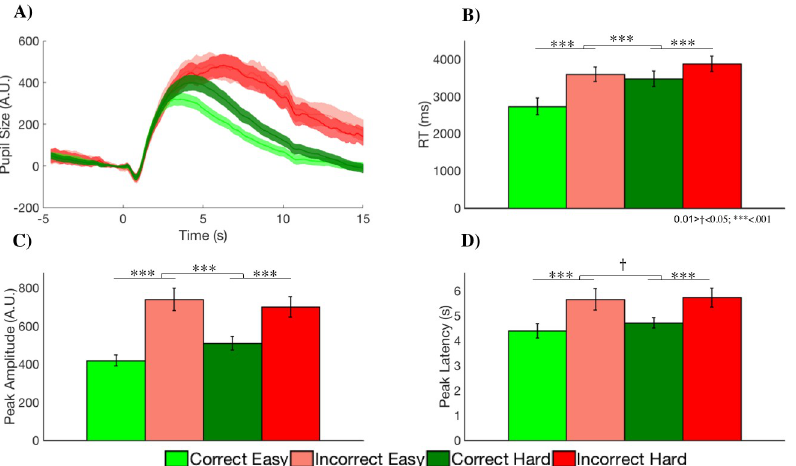
Fig 3. ( A) Mean task-evoked pupil responses (in arbitrary units: A.U.) by task condition (easy, hard) and accuracy (correct, incorrect). (B) Bar plots illustrate how performance (mean response time) was modulated by difficulty